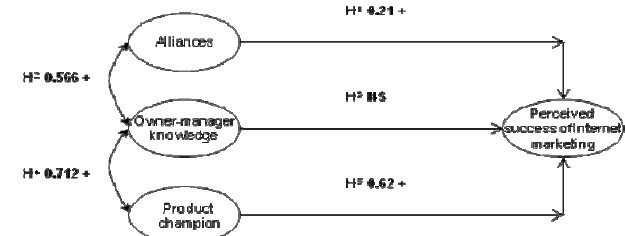
Figure 2: Structural model estimation